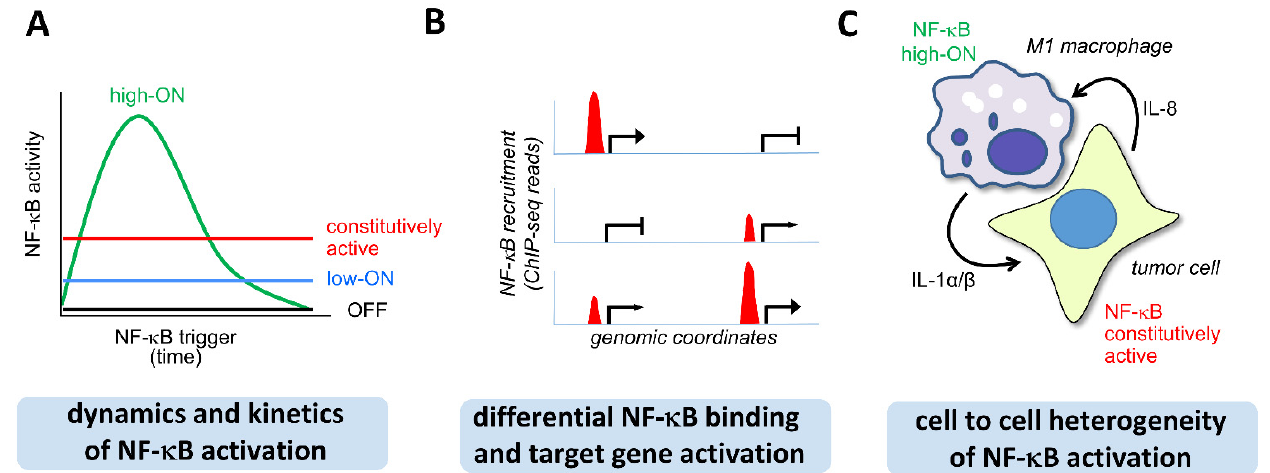
Figure 1. The three layers of NF- κ B activation states. ( A ) Schematic representation of different modes of NF- κ B activity. ( B ) Schematic showing various possibilities of NF- κ B binding to specific genomic loci and the functional consequences on transcription. ( C ) Cellular heterogeneity of NF- κ B activation, as exemplified by the interaction between a tumor cell and a neighboring macrophage.